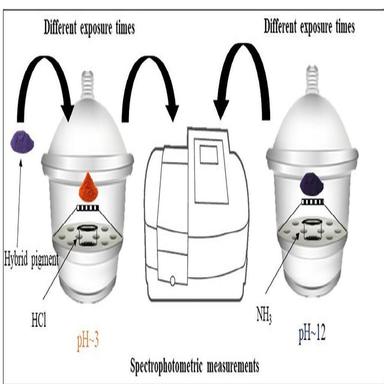
pH-sensing experiment.